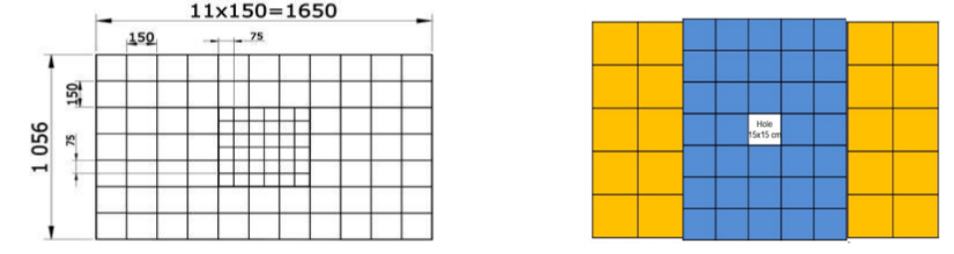
Figure 2. (Left) Schematic view of the ZDC BM@N. (Right) Proposed geometry of new FHCal